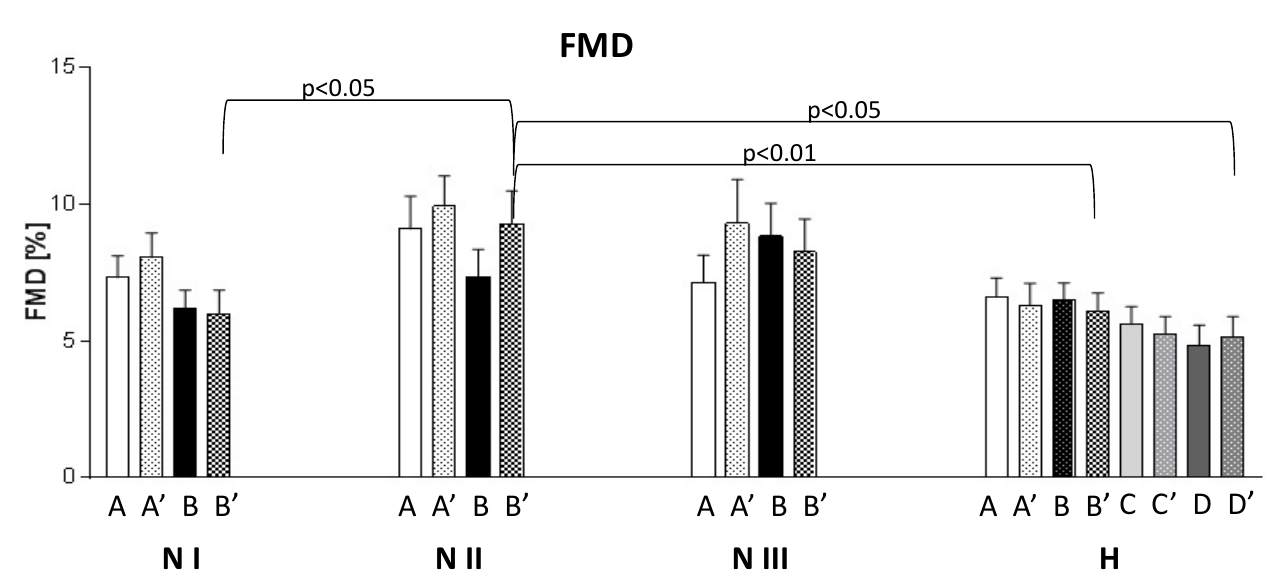
Figure 5. Flow-mediated dilatation (FMD). A—baseline; B—after ASA; C—after valsartan; D—after valsartan and ASA; FMD before (study A, B, C, D) and after L -Arg administration (study A’, B’, C’, D’). Table 2. Blood pressure measurements at the beginning and at the end of study protocol (for normotensives—A and B, for hypertensives A and D).